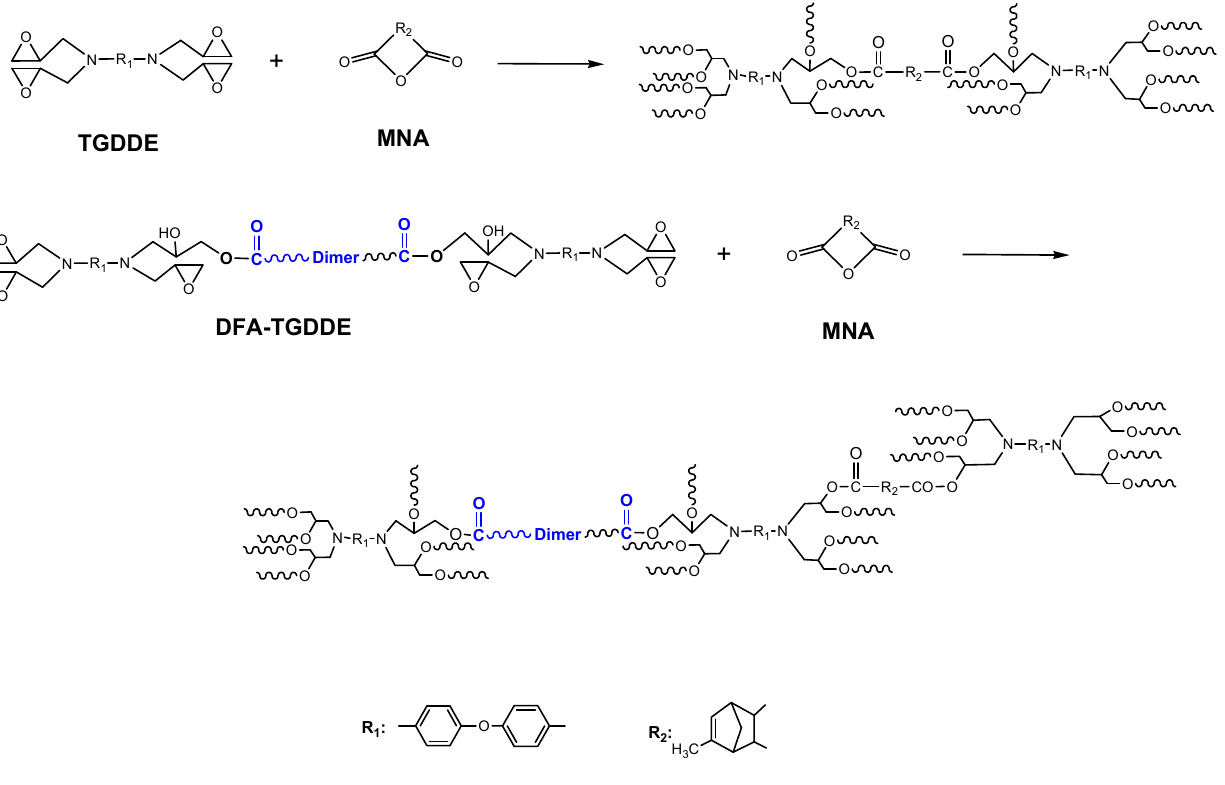
Scheme 2. The curing reaction of TGDDE/methyl nadic anhydride (MNA) and DFA-TGDDE/MNA